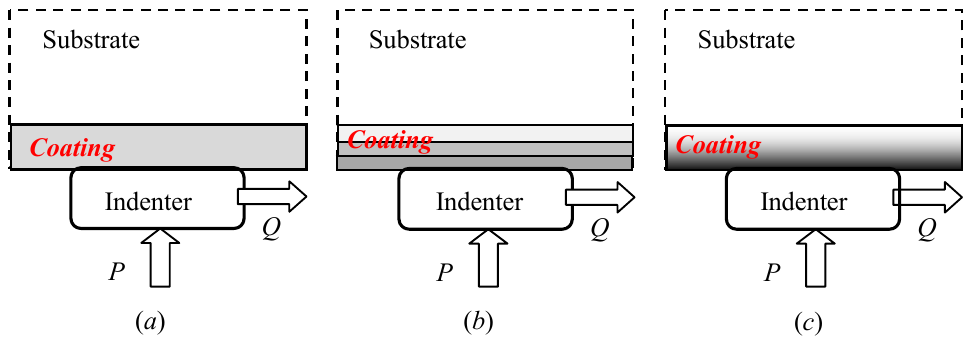
Figure 10. Contact systems with: ( a ) Single layer coating; ( b ) Multi-layer coating; ( c ) Functionally graded material coating (FGM). P and Q stand for normal and tangential loads, respectively.